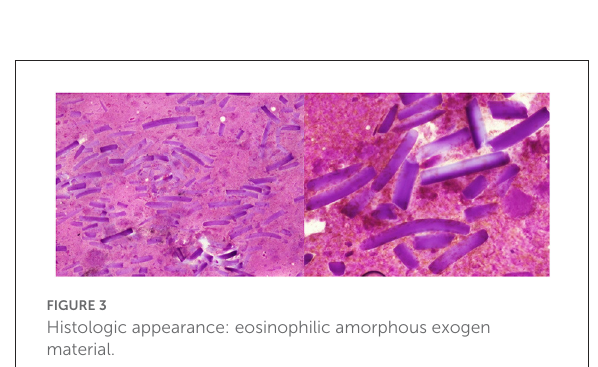
FIGURE3 Histologic appearance: eosinophilic amorphous exogen